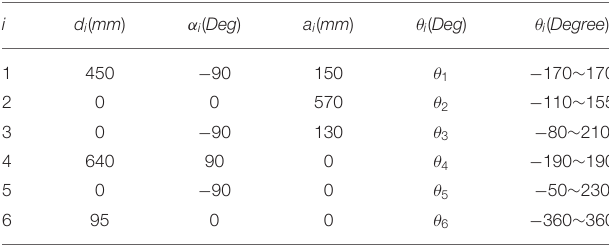
TABLE 1 | The DH parameters of the 6-DOF